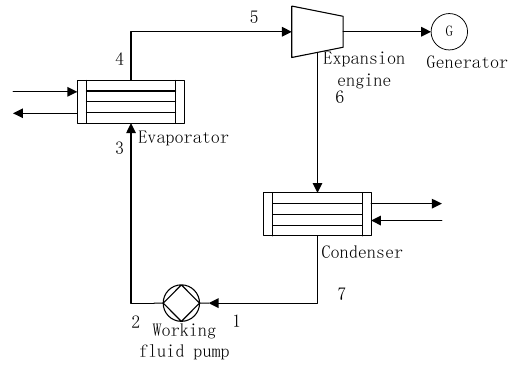
Figure 1. Structure of the ORC power generation system.